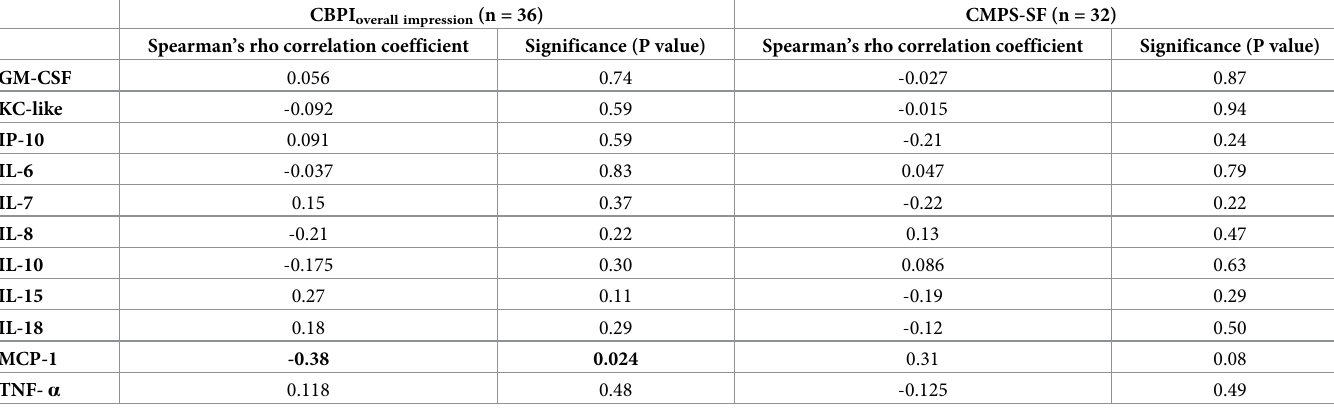
Table 6. Results of the statistical analysis evaluating the association between cytokines concentrations and a) owners’ perception of their dog’s quality of life b) CMPS-SF.